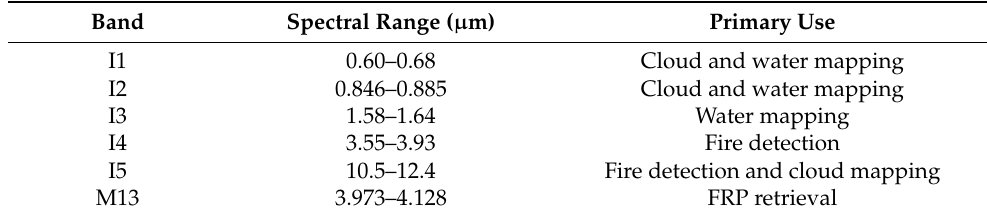
Table 1. Spectral bands used to generate VIIRS active fire [6].